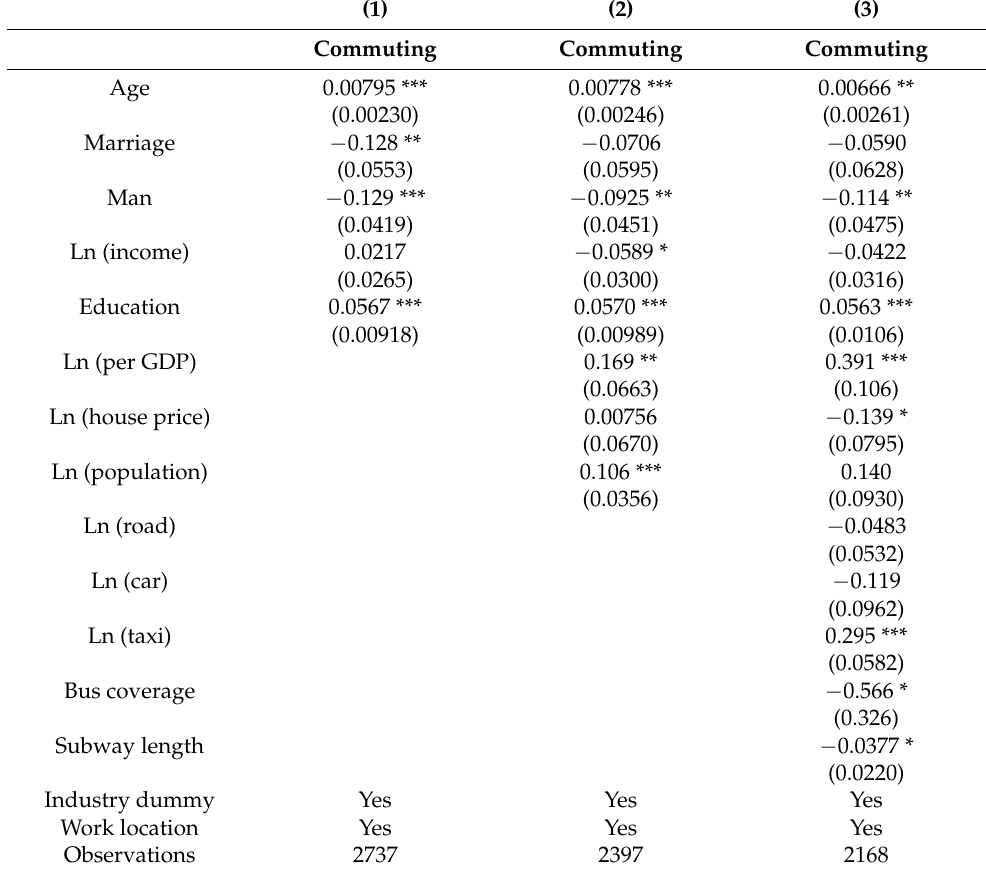
Table 4. Transport and commuting